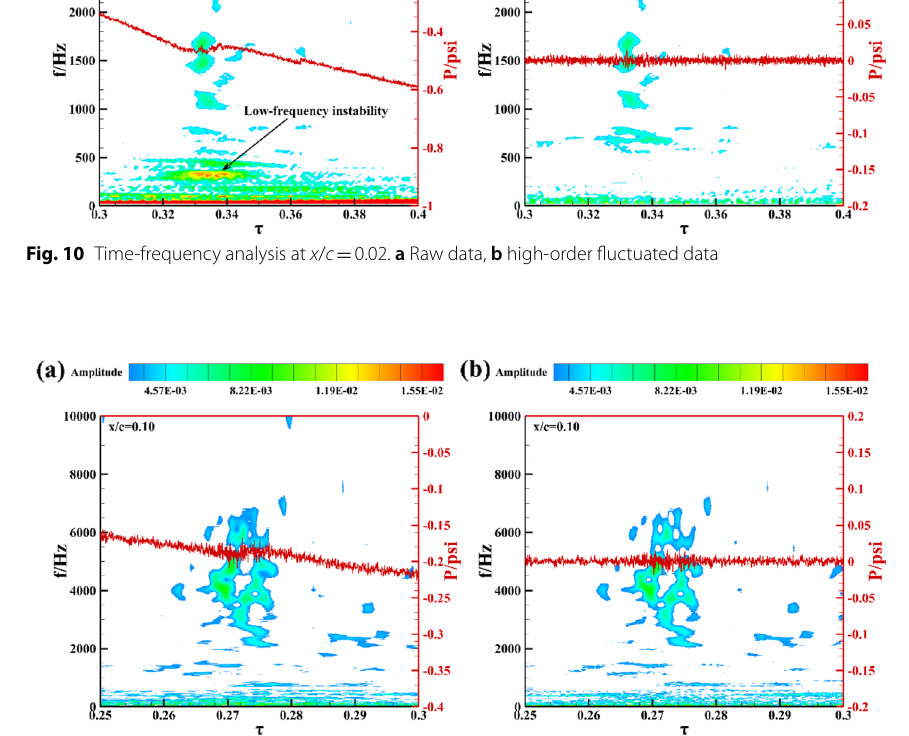
0.10. a Raw data, b high-order fluctuated =